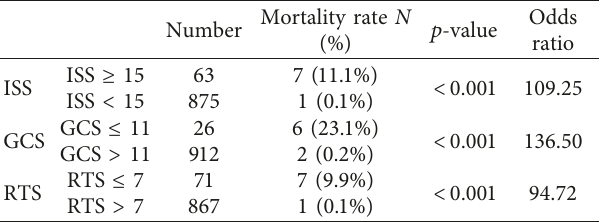
Table 5: Association of trauma score’s cutoff value with mortality. Mortality rate N Number